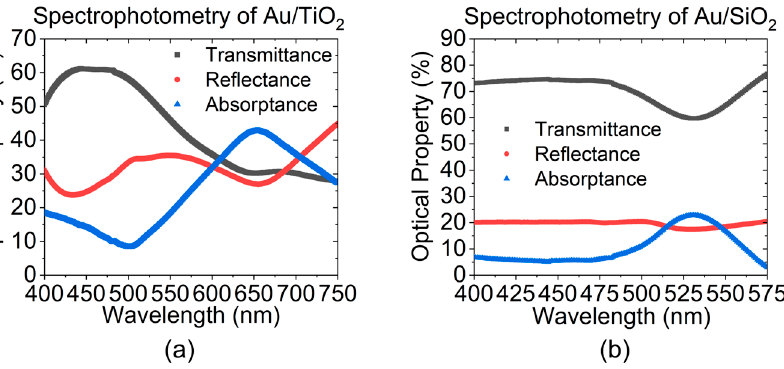
Figure 3. Spectrophotometry of ( a ) Au/TiO 2 and ( b ) Au/SiO 2 nanocomposites on planar quartz substrates showing representative LSPR absorption bands in the visible range.